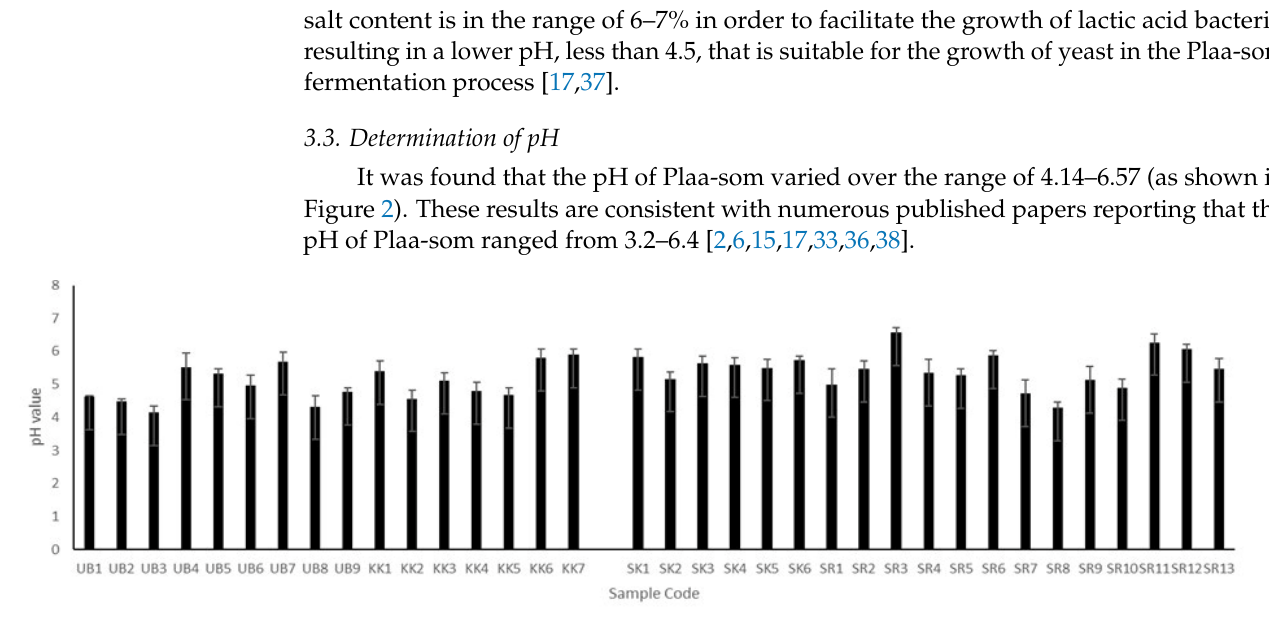
Figure 2. The pH values of Plaa-som samples from 4 provinces: Ubon Ratchathani (UB), Khon Kaen (KK), Sisaket (SK), and Surin (SR).